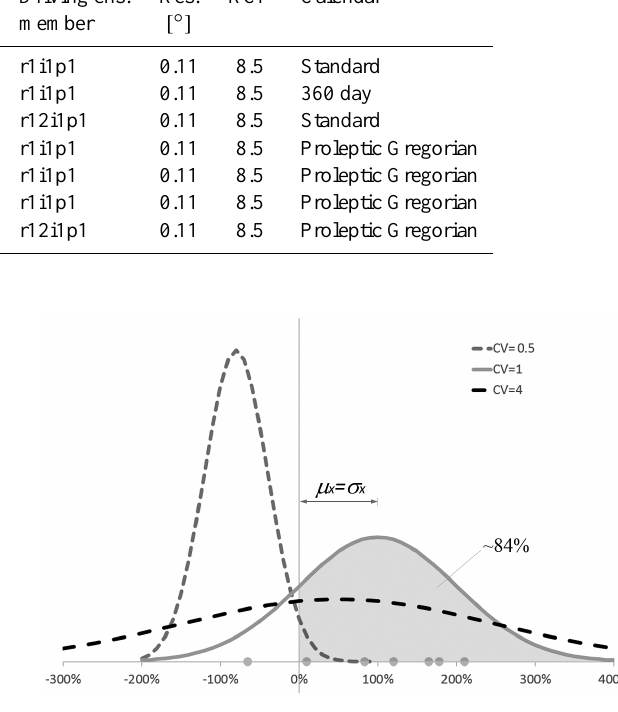
Figure 2. Schematic view of the coefficient of variation of the rela- tive error.